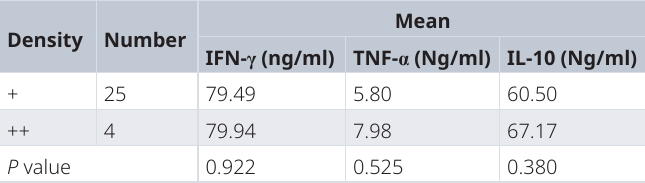
Table 6. Correlation between parasitemia and cytokine profiles.